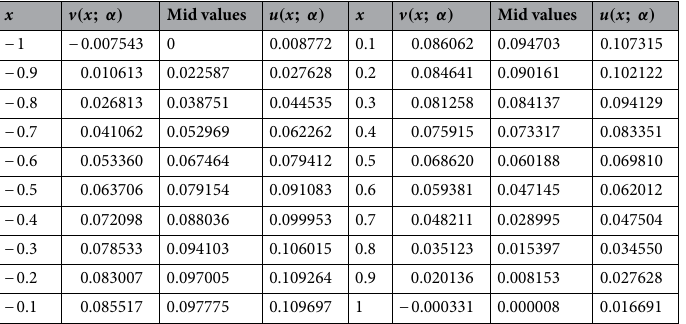
Table 5. Fuzzy solution of v ( x , α) , mid and u ( x , α) at fixed values of α -cut = 0, m = 0.2, β = 0.3, and p = 0.2, with distinct values of x